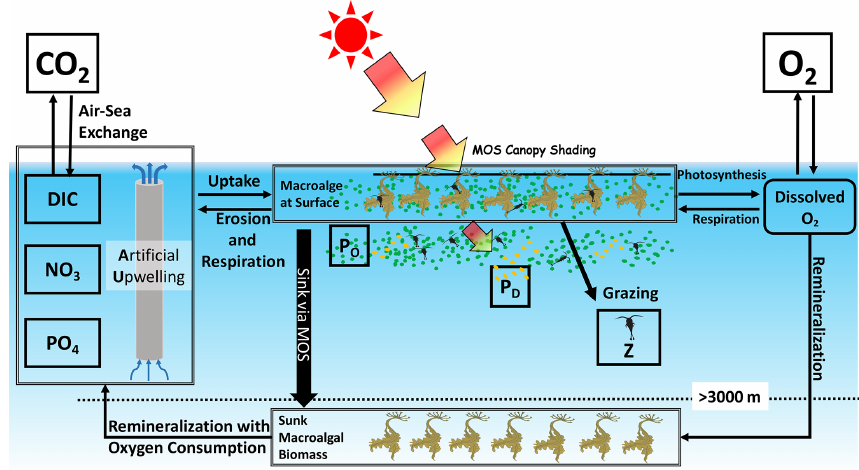
Figure 1. Schematic illustrating the biogeochemical fluxes and physical impacts of MOS on nutrients (NO 3 and PO 4 ), oxygen, dissolved inorganic carbon (DIC), ordinary phytoplankton ( P O in green), diazotrophs ( P D in pale brown) and zooplankton ( Z